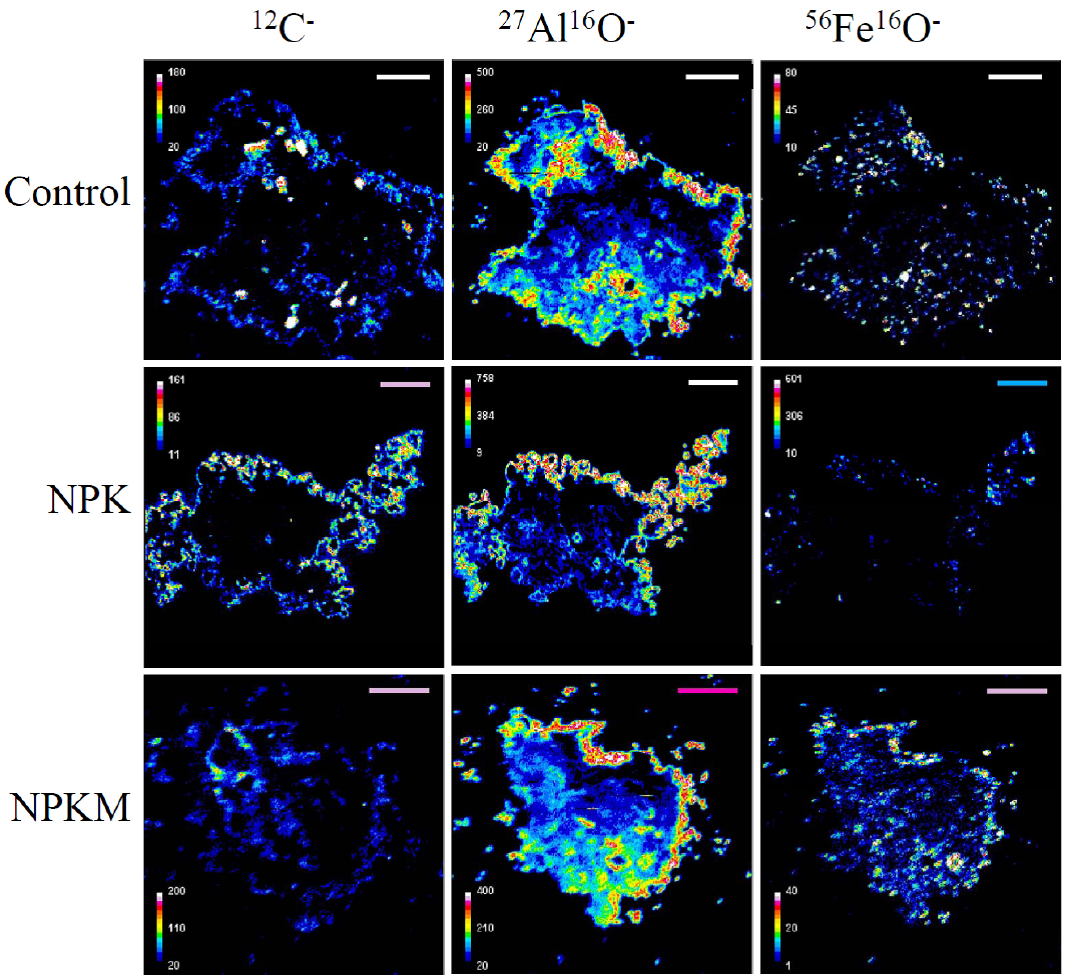
Figure 2. Representative NanoSIMS images of 12 C − , 27 Al 16 O − , and 56 Fe 16 O − in soil colloids from three contrasting long-term (1990– 2014) fertilization treatments (control, no fertilization, 28 × 28µm 2 ; NPK, chemical nitrogen, phosphorus, and potassium fertilization, 30 × 30µm 2 ; NPKM, chemical NPK plus swine manure fertilization, 25 × 25µm 2 ) . Note that the color intensity calibration bar displayed in the chemical maps corresponds to the relative concentrations of individual elements, but cannot be used to compare one element with another. Bar =